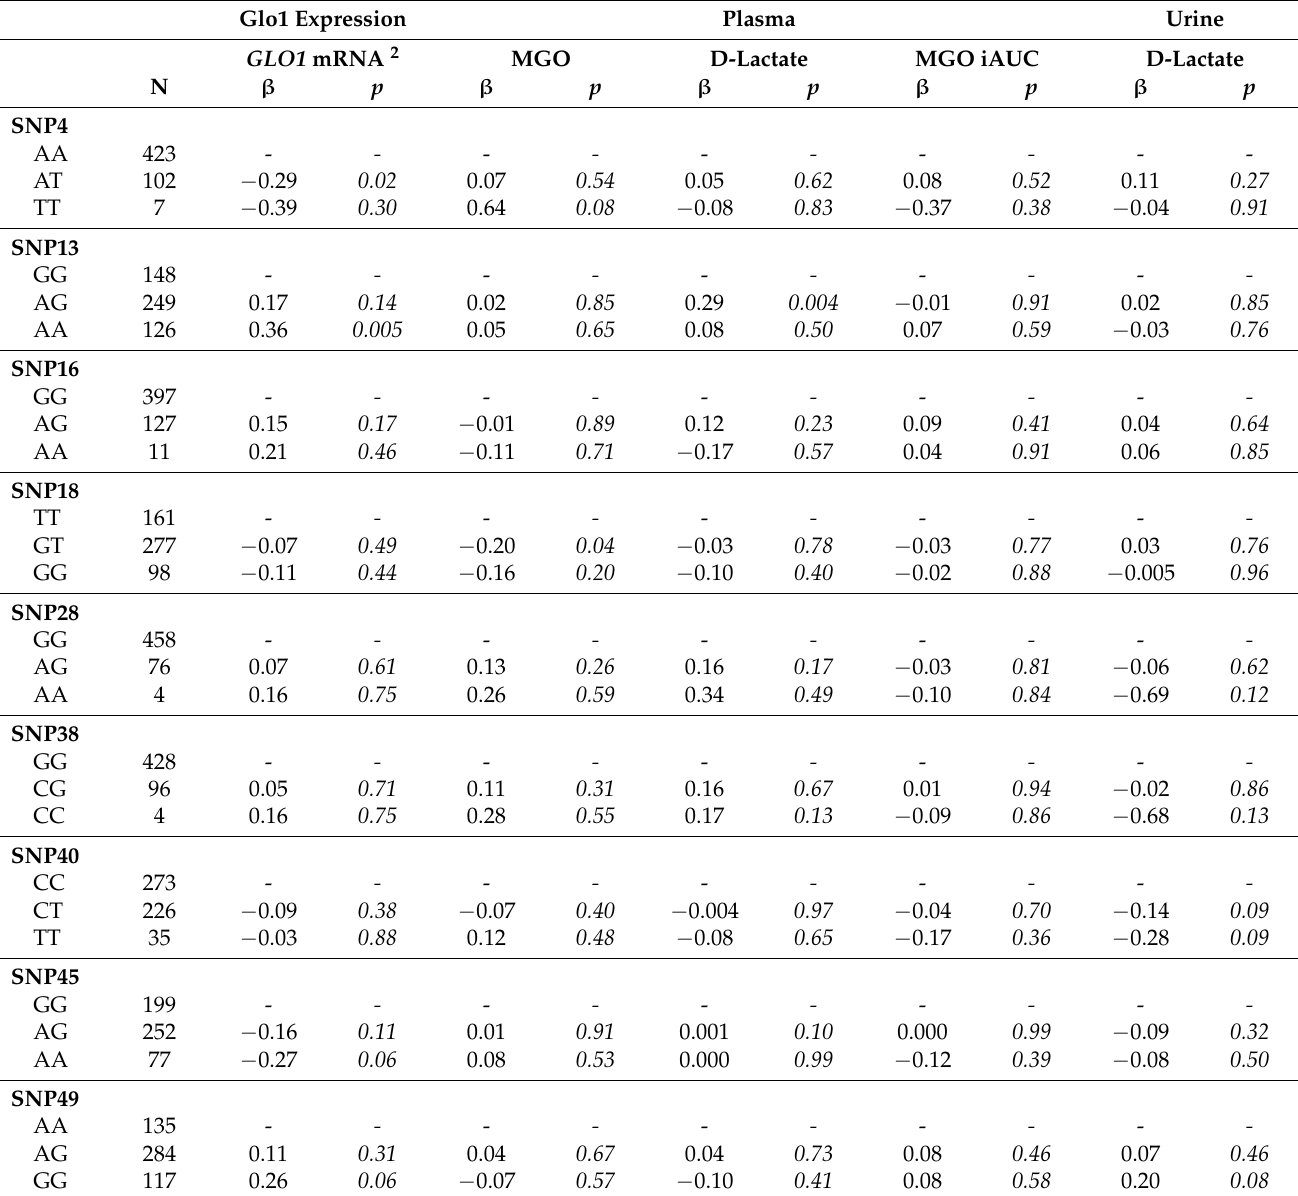
1 Data are analyzed using linear regression analysis, adjusted for age, sex, and glucose metabolism status (impaired glucose metabolism and type 2 diabetes as dummy variables with normal glucose metabolism as reference). The genotype with the highest frequency was used as reference, with the other two genotypes added as dummy variables. All outcome variables were standardized and, apart from fasting plasma MGO, all outcome variables were ln-transformed prior to standardization. 2 GLO1 mRNA expression as measured in white blood cells, expressed as ratio of Glo1 versus reference genes. GLO1, glyoxalase-1; iAUC MGO, incremental area under the curve of MGO after an OGTT; MGO, methylglyoxal; OGTT, oral glucose tolerance test; SNP, single nucleotide